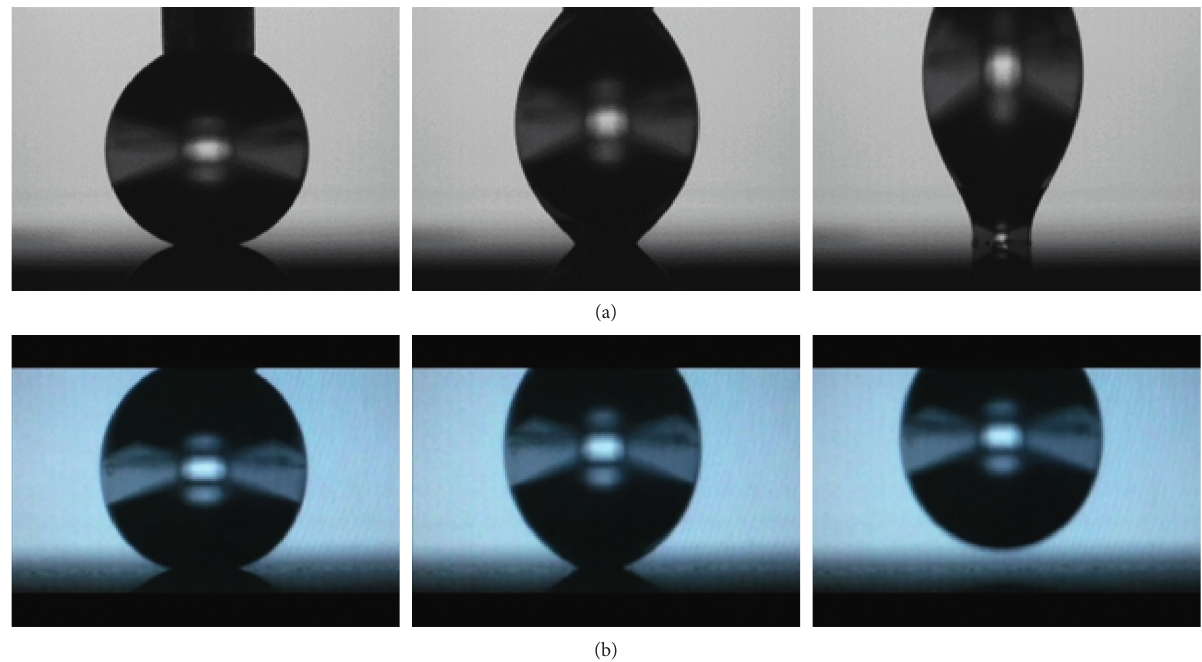
Figure 6: Adhesive property of S1: (a) before fluorination and (b) after